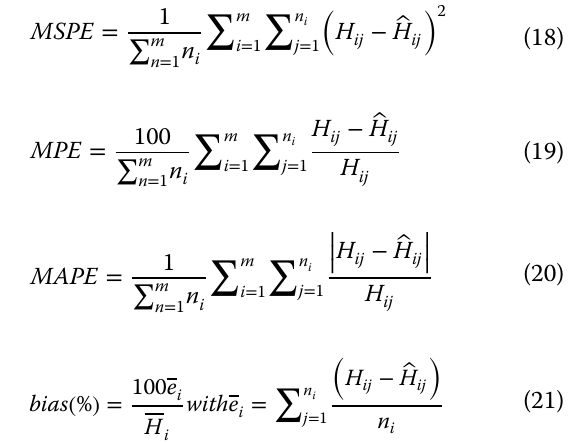
Table 13 Calibration results of NLME H–D models of A. araucana Alternatives